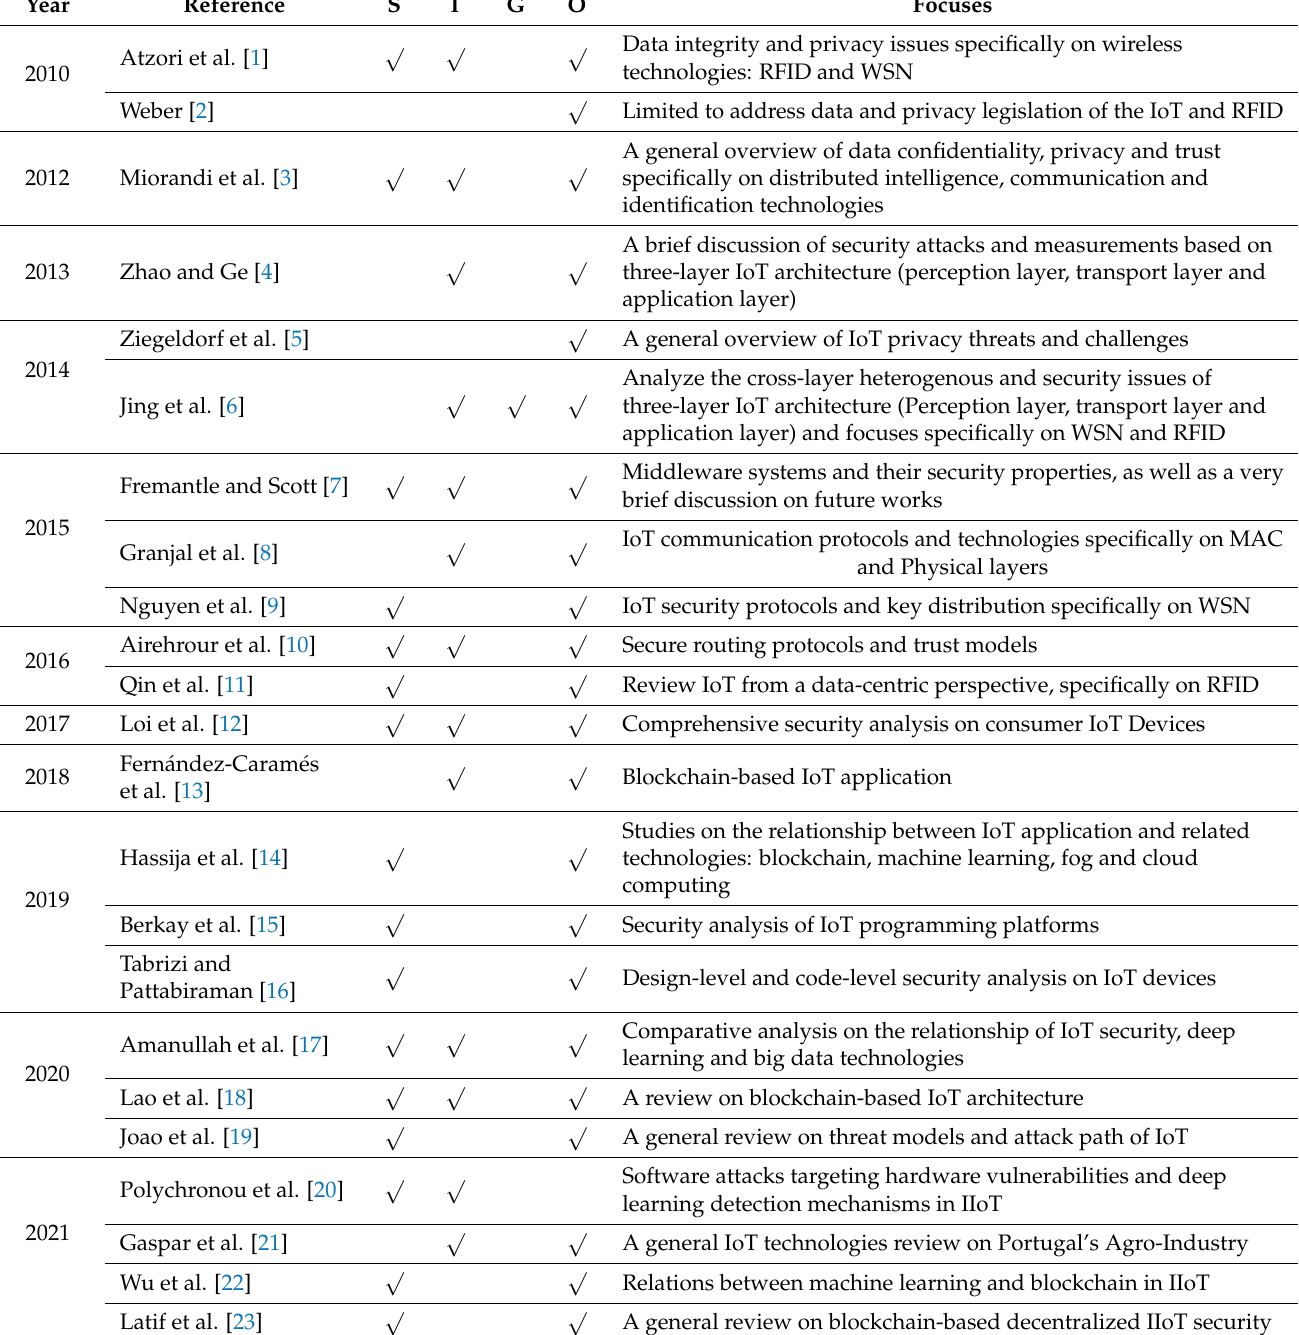
Table 1. Chronological summary of previous surveys in the IoT and IIoT